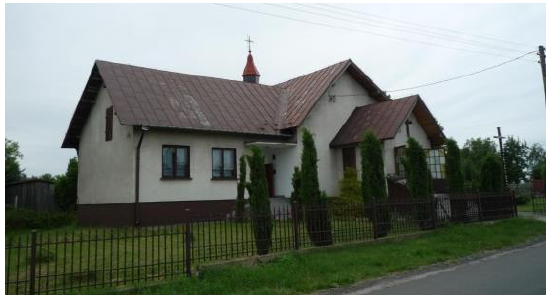
Figure 13. Church of St. John the Baptist in Kocin Stary (built in 1982–90).